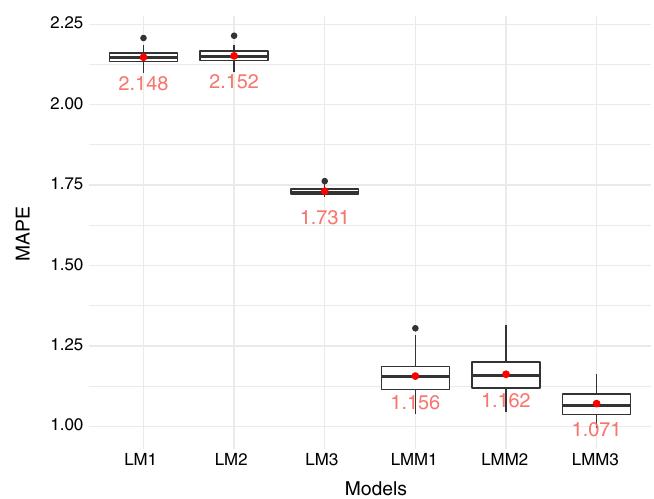
Fig. 5 MAPE values with the average printed in red color